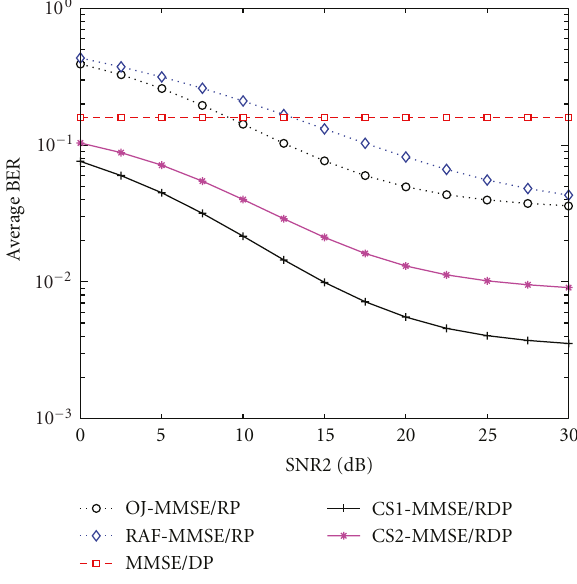
Figure 4: BER versus SNR of RS-MS link in downlink ( p = 0 . 4, SNR1 = 15dB) .